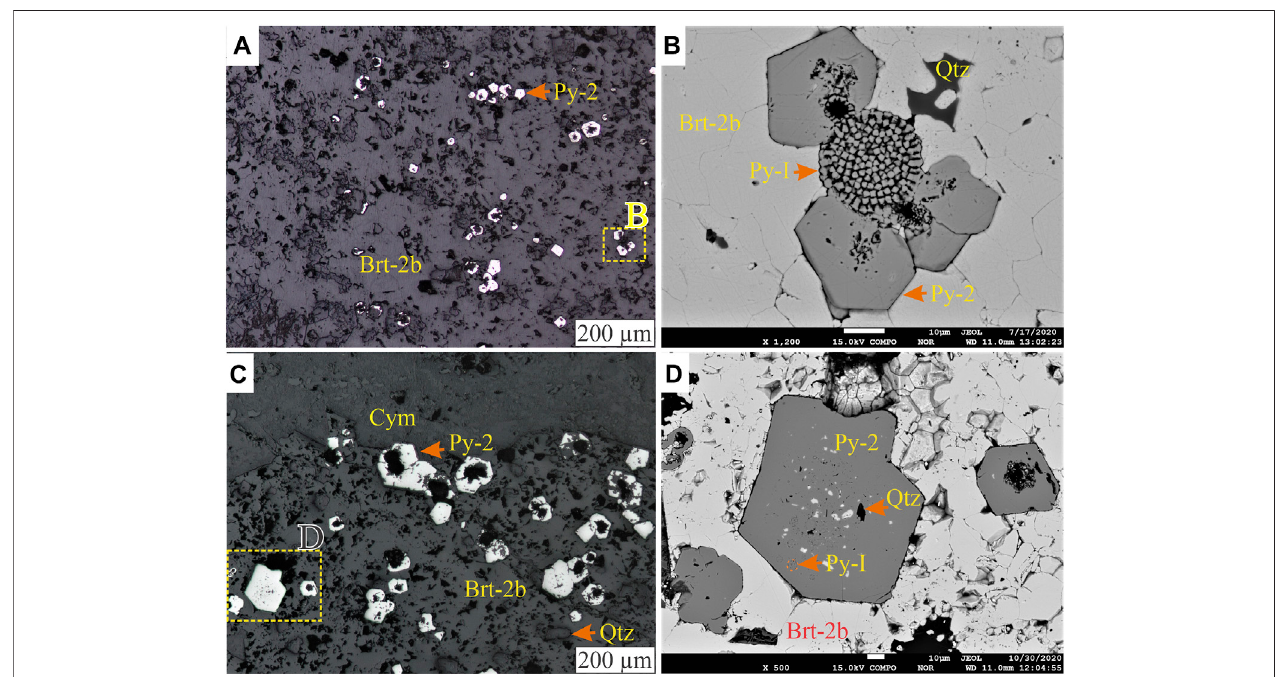
FIGURE 8 | (A) Re fl ected light photomicrograph of nodular barite (Brt-2b) with interlocking grains and intergrowing subhedral to euhedral pyrite (Py-2). (B) BSE image of the highlighted region in A showing the intergrowth relationship between Py-2 and Brt-2b. (C) Re fl ected light photomicrograph of Py-2 with porous cores that contain Py-1, barite, and quartz (quartz) inclusions, better highlighted in BSE image (D) .